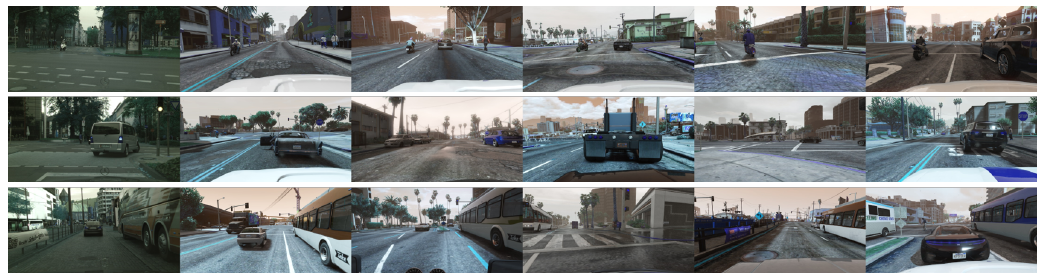
Figure 7. Target domain image and the five corresponding images matching by COCM.